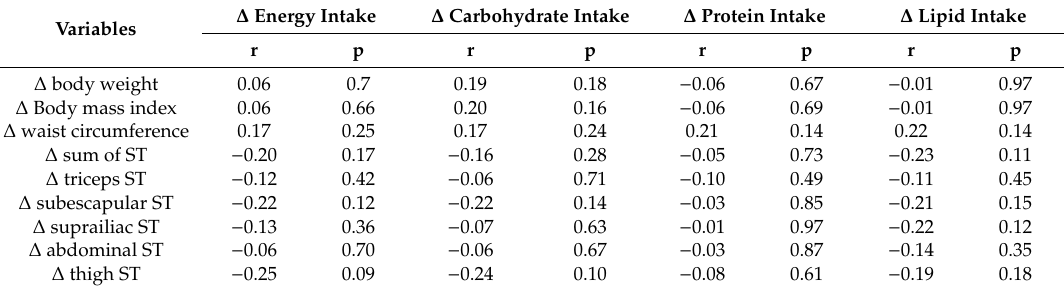
Table 1. Correlations between changes in nutritional factors and changes in anthropometric measures. ∆ Energy Variables